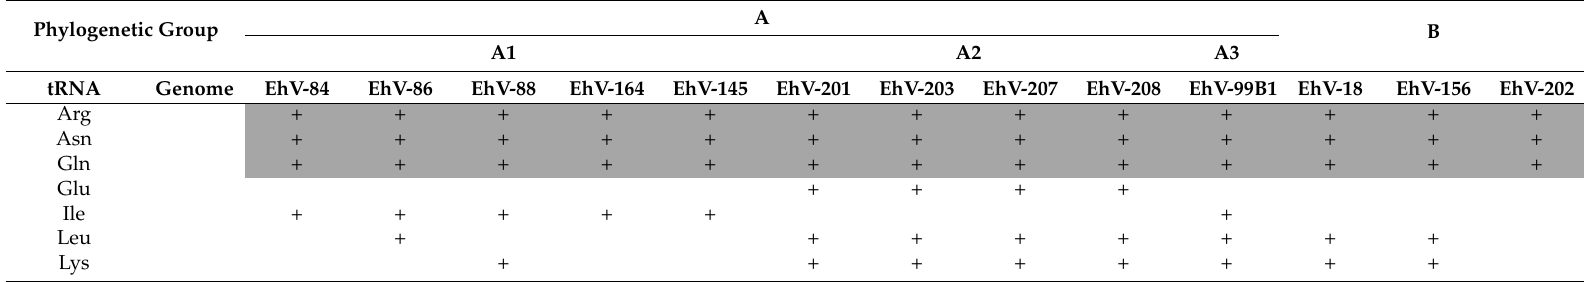
Table 4. Genes predicted to encode tRNAs in the genomes of 13 coccolithoviruses. Their presence (+) in each genome is indicated, and in grey shaded cells are those tRNAs common to all genomes. The phylogenetic clade of each genome (based on their DNA polymerase gene) is indicated above the column headers (see Figure 1). It is important to note that some of these tRNAs may still be present in the genomes of some EhVs in the unsequenced parts between the different contigs. Phylogenetic Group